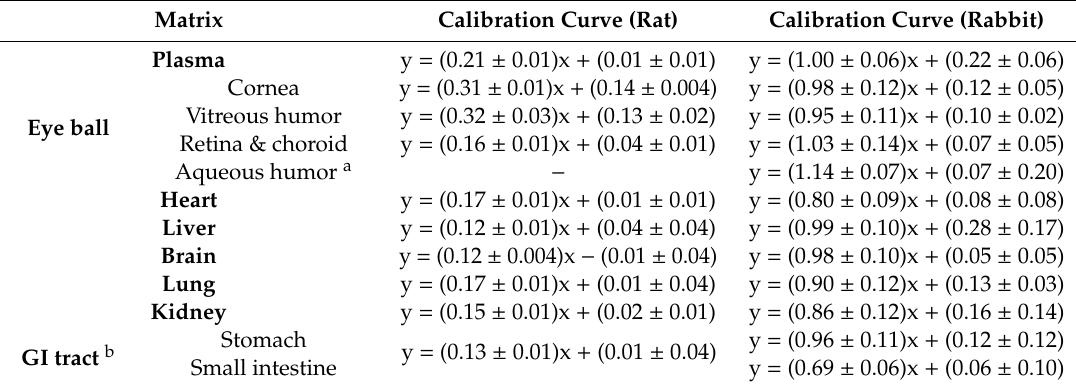
Table 1. Calibration curves of CK41016 in plasma and tissues of rats and rabbits. Matrix Calibration Curve